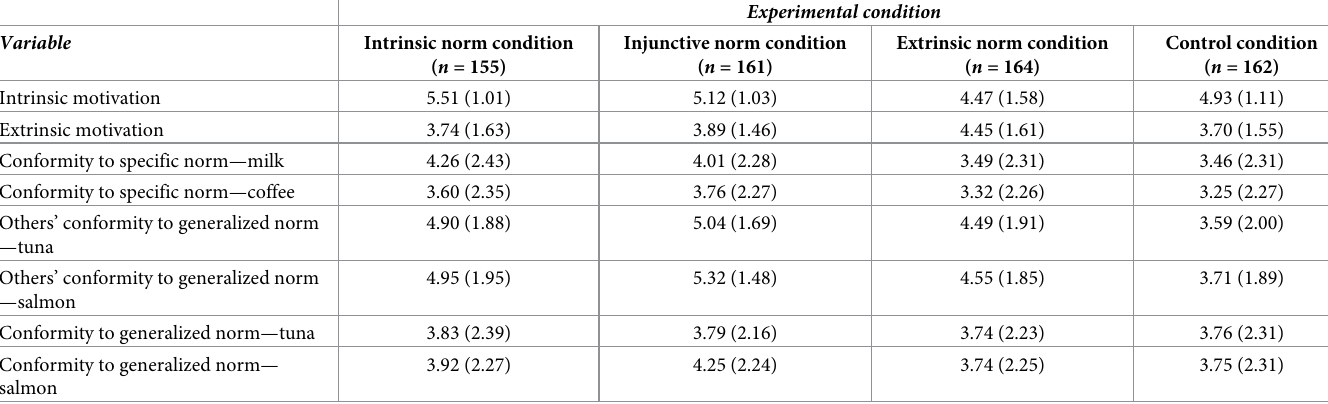
Table 3. Descriptive summary of M (SD) of manipulation checks and dependent variables by experimental